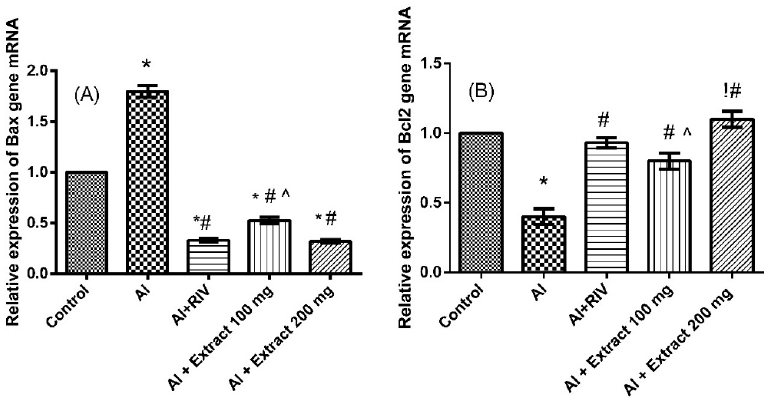
Figure 5. Effect of H. abyssinica extract on mRNA relative expression of ( A ) Bax and ( B ) Bcl2 in hippocampus. * Significant difference from control group at p ˂ 0.0001, # significant difference from AlCl 3 group at p ˂ 0.0001, ^ significant difference from RIV group at p ˂ 0.001, ! significant differ- ence from 100 mg group at p ˂ 0.0001. Mean ± SE.